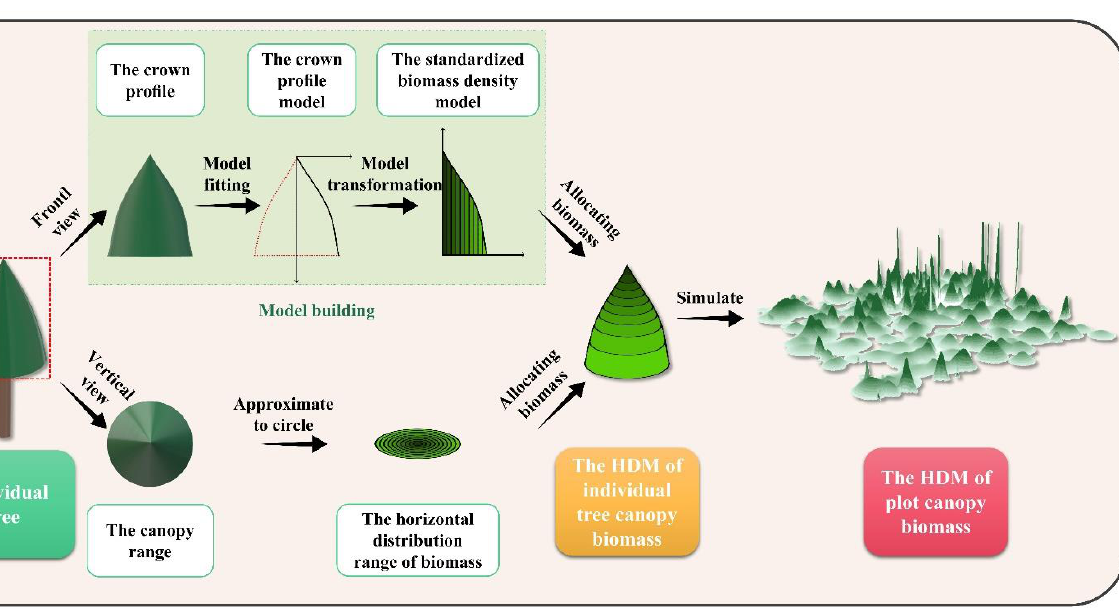
Figure 2. Simulation process of horizontal distribution of canopy biomass in the plot.